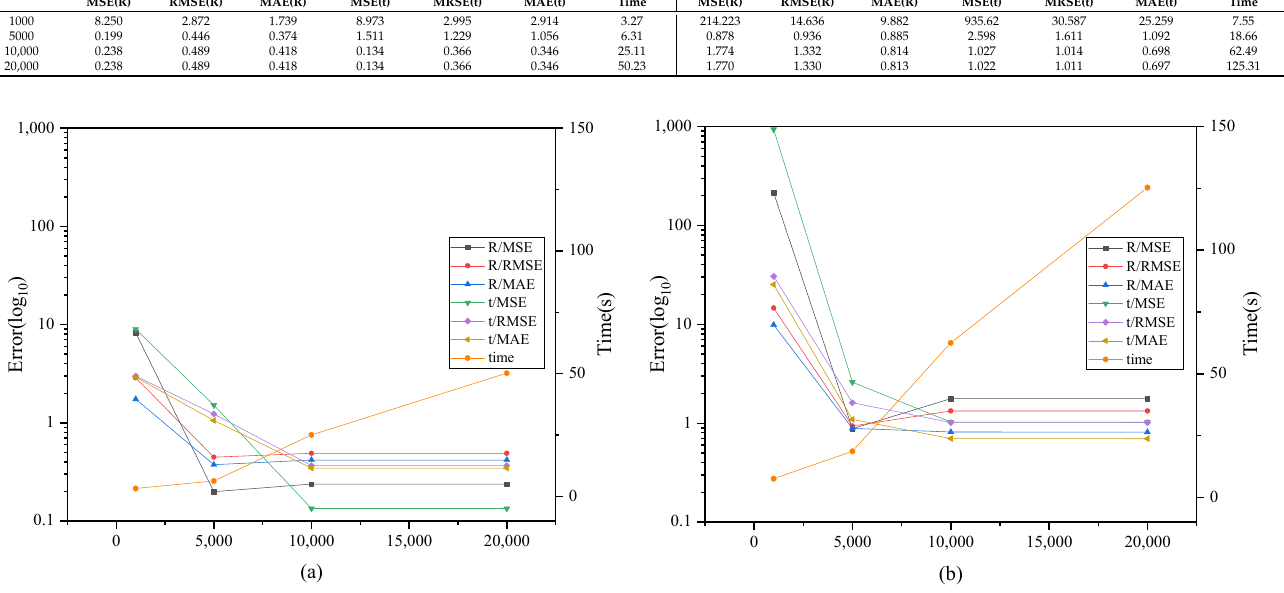
Figure 4. Each line shows registration error and time cost with respect to the maximum number of iterations, (a) Our method, (b) Traditional RANSAC method.